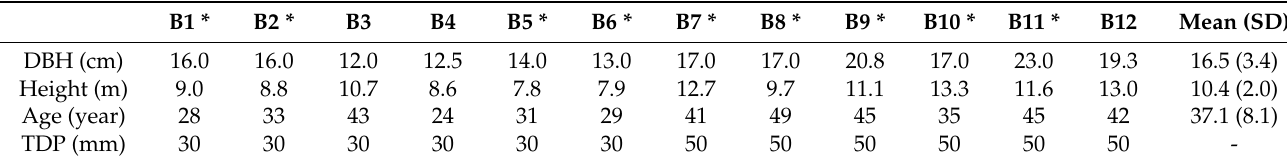
Table 3. Diameter at breast height (DBH), height and age of the burned trees and length of heat dissipation probes (TDP). Chlorophyll fluorescence and gas exchange measurements were made on the trees indicated by an